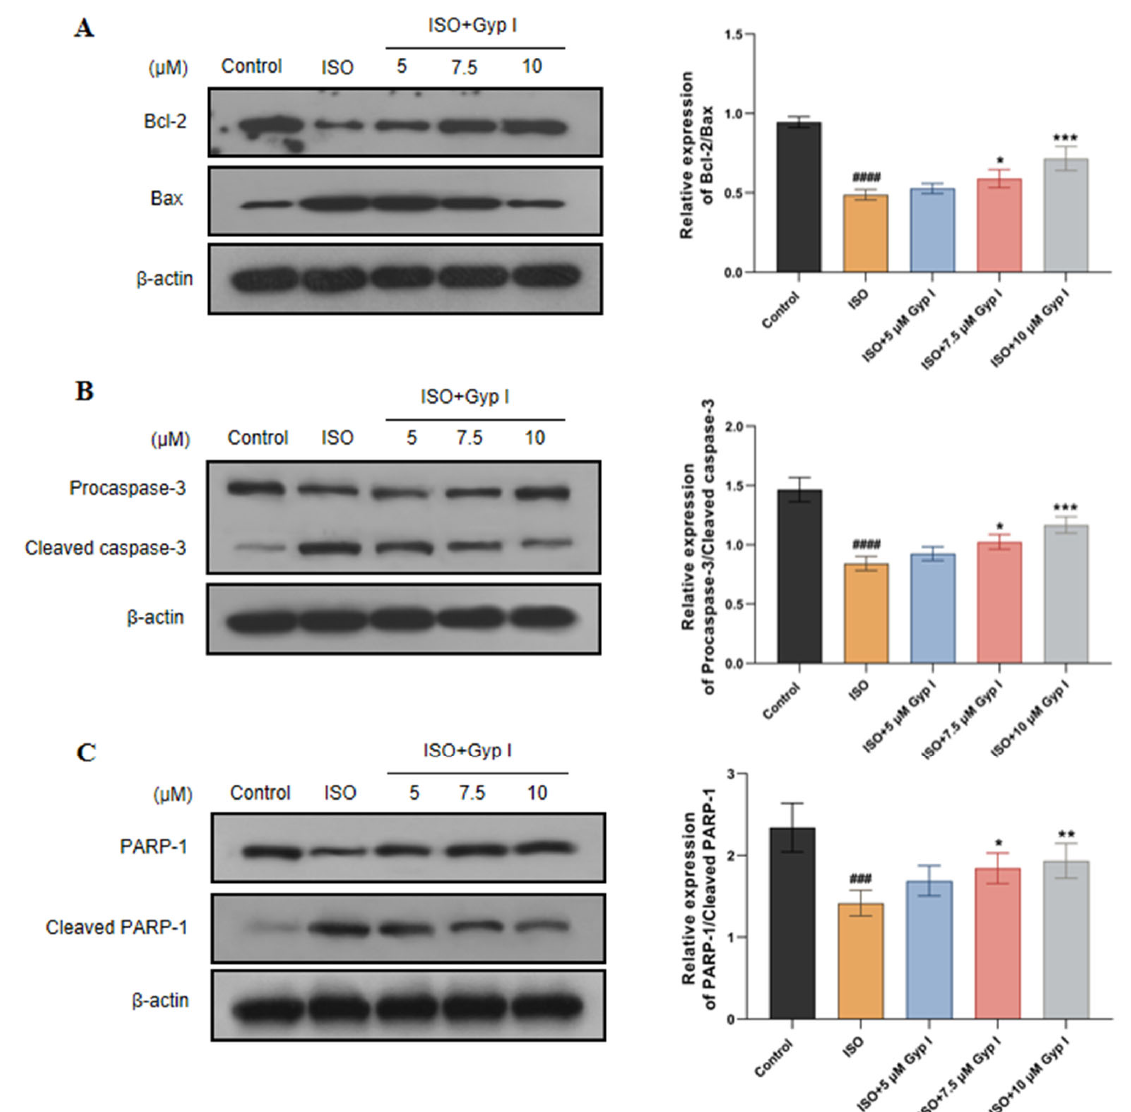
Figure 3. Effects of Gyp I on the expression of apoptosis ‐ related proteins in ISO ‐ induced H9c2 cells were analyzed by Western blot: ( A ) Protein expression assay of Bcl ‐ 2 and Bax. ( B ) Protein expression assay of Procaspase ‐ 3 and Cleaved caspase ‐ 3. ( C ) Protein expression assay of PARP ‐ 1 and Cleaved PARP ‐ 1. Results are presented as mean ± SD of three independent experiments using one ‐ way ANOVA followed by Tukey’s multiple ‐ comparison test (###: p < 0.001, ####: p < 0.0001 compared with Control group; *: p < 0.05, **: p < 0.01, ***: p < 0.001 compared with ISO group).